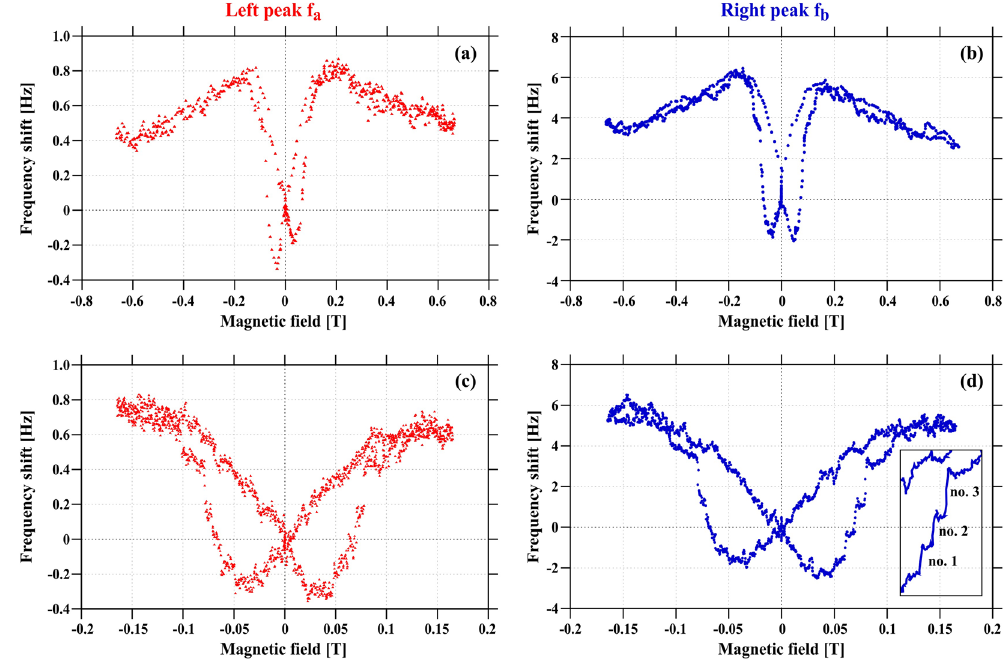
Figure 2. Field-dependent frequency shift signal for the co-resonantly coupled sensor obtained at the microcantilever by laser-deflection, ( a ) left-hand side resonance peak ( f a ) for the full range of external magnetic field, ( b ) right-hand side resonance peak ( f b ) for the full range of external magnetic field, ( c ) left-hand side resonance peak ( f a ) with higher resolution for external magnetic field of ± 160 mT, ( d ) right-hand side resonance peak ( f b ) with higher resolution for external magnetic field of ± 160 mT. The inset in ( d ) depicts part of the curve with the dots connected for better visualization of the